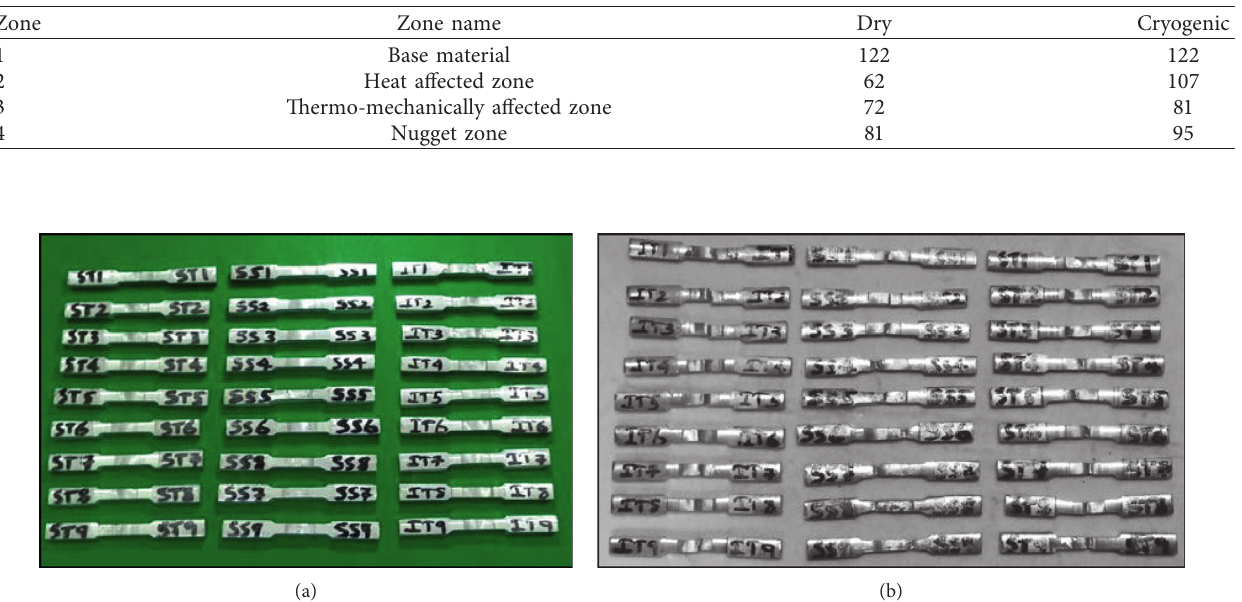
Figure 14: FSW specimens taken (a) before and (b) after the tensile